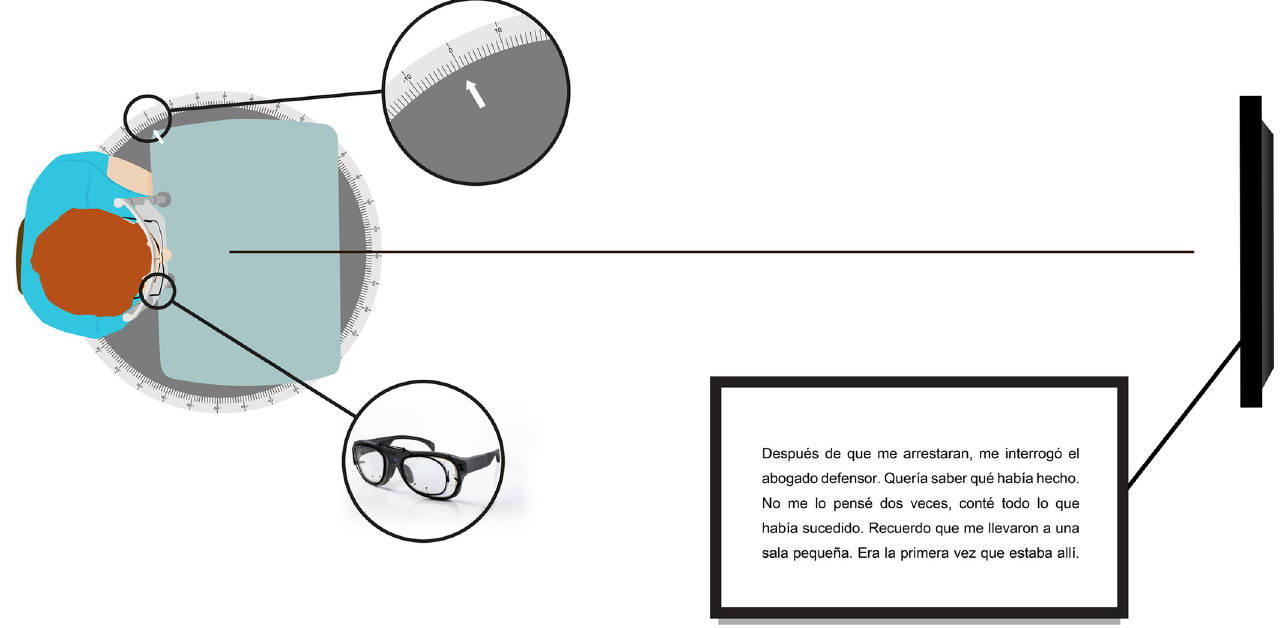
Fig 3. Scheme of the evaluation of reading performance using ET technology at distance reading vision.